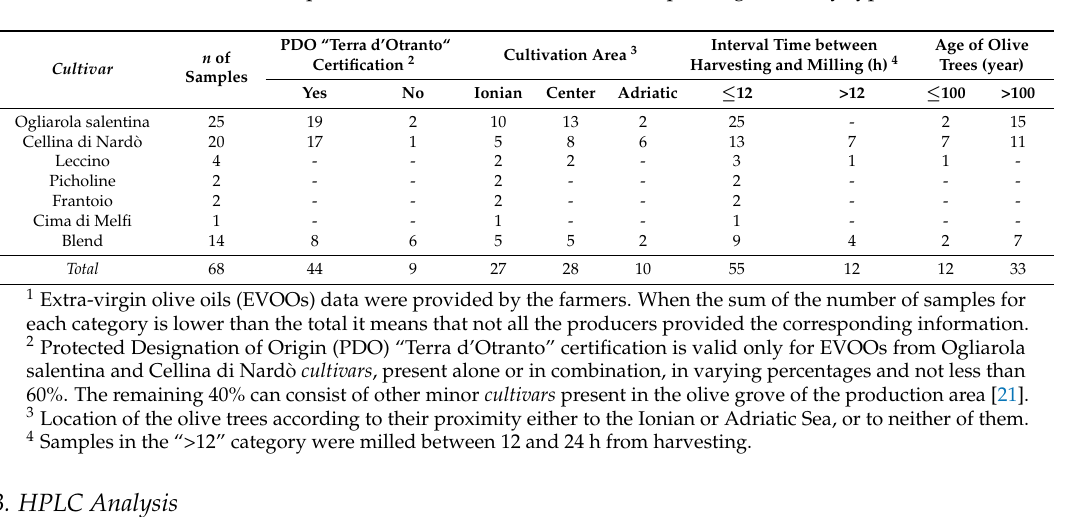
Figure 2. Map of Italy with a zoom on a southern Apulia region (Salento, in red). The colored shapes represent the sites of production of the extra-virgin olive oils (EVOOs) categorized according to their proximity either to the Adriatic (green circles) or Ionian Sea (red triangles), or to neither of them (blue squares). Table 1. Technical info and production details about EVOO samples organized by type of cultivar .